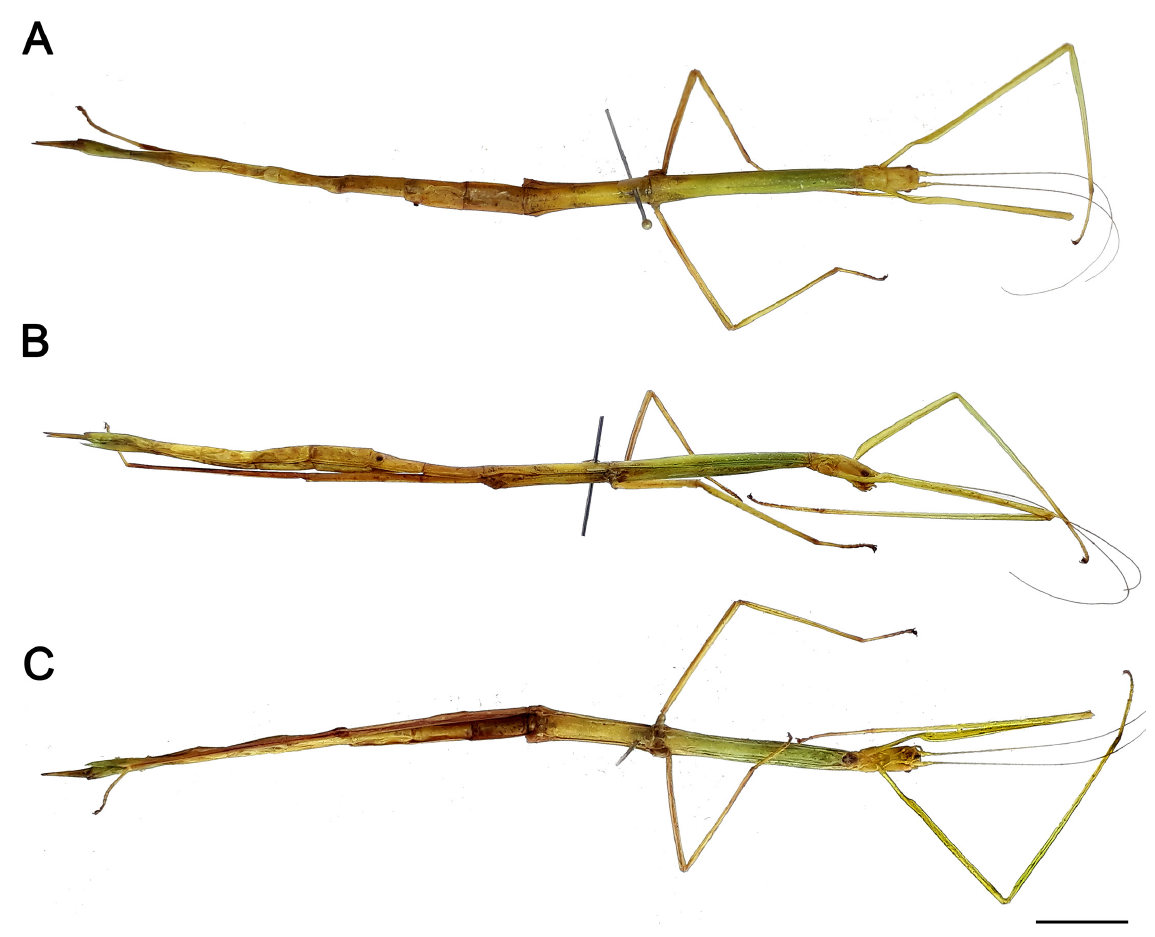
Fig. 14. Arumatia anyami Ghirotto, Crispino & Neves gen. et sp. nov., holotype, ♀ (MZUSP 1091). A . Dorsal view. B . Lateral view. C . Ventral view. Scale bar: 10